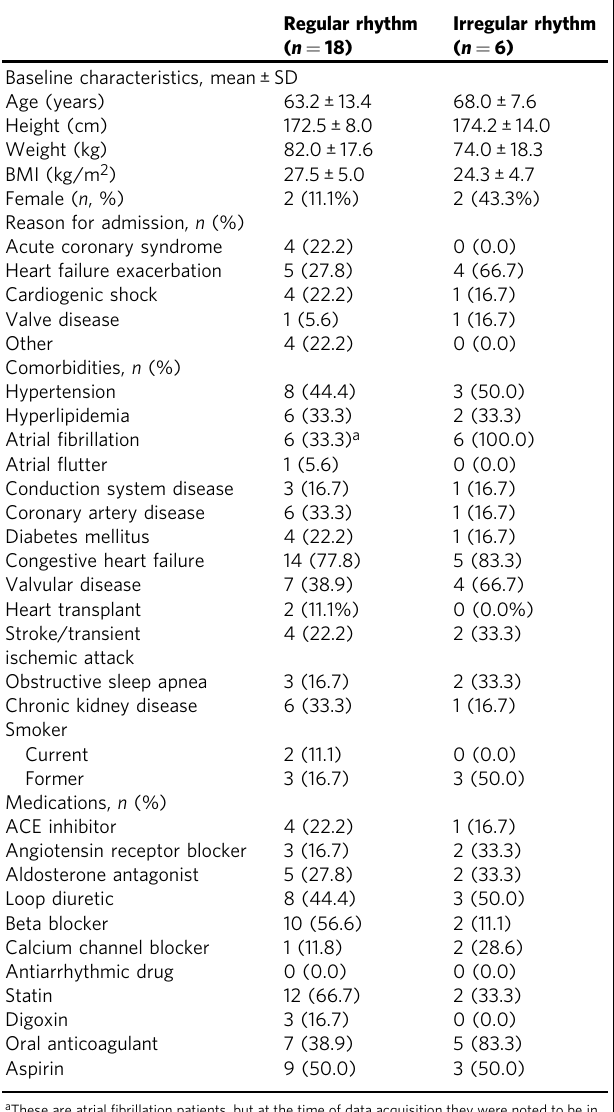
Regular rhythm Irregular rhythm ( n = 18) ( n = 6)